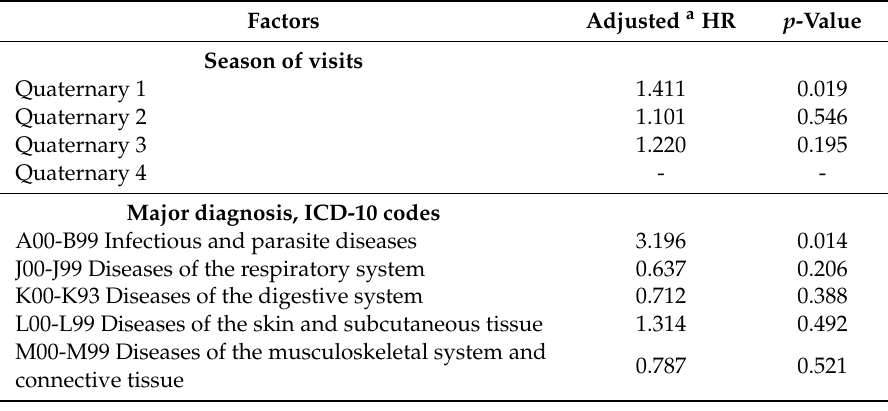
Table 4. Correlation factors of immigrant workers compared with natives following multivariate regression